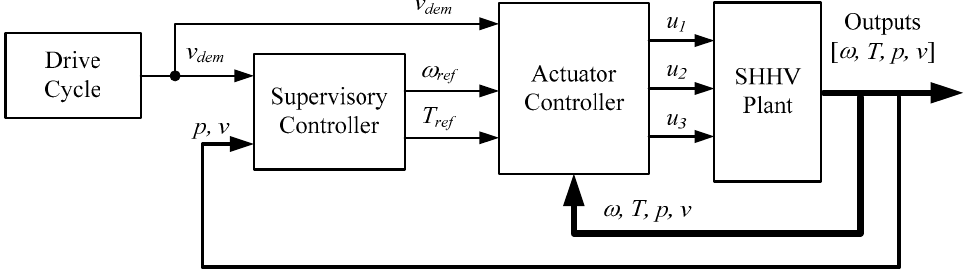
Figure 4. Hierarchical Control System of the SHHV.